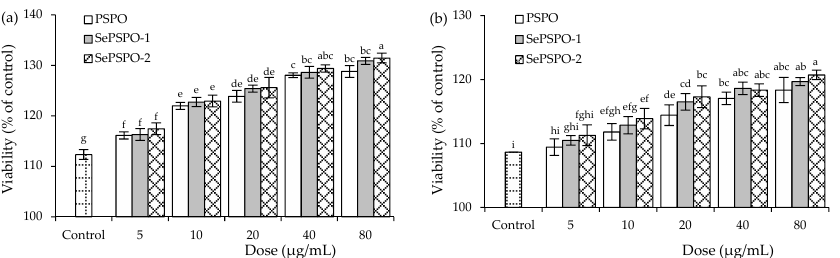
Figure 2. The measured viability values (%) of the splenocytes incubated with PSPO, SePSPO-1, and SePSPO-2 for 48 h and stimulated by Con A ( a ) or LPS ( b ). Different letters lowercase above the columns suggest that the one-way ANOVA of the mean values is significantly different ( p < 0.05). 3.4. Cytokine Secretion of the Murine Splenocytes as Affected by the PSPO and SePSPO